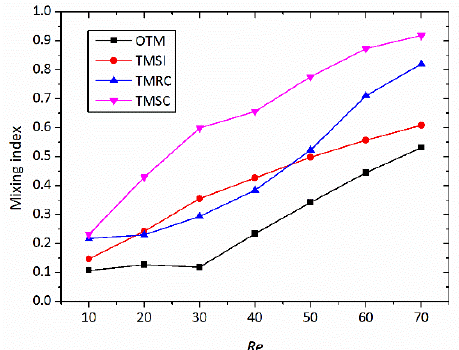
Figure 5. Variations of mixing index at the middle section of different micromixer at different Reynolds number.